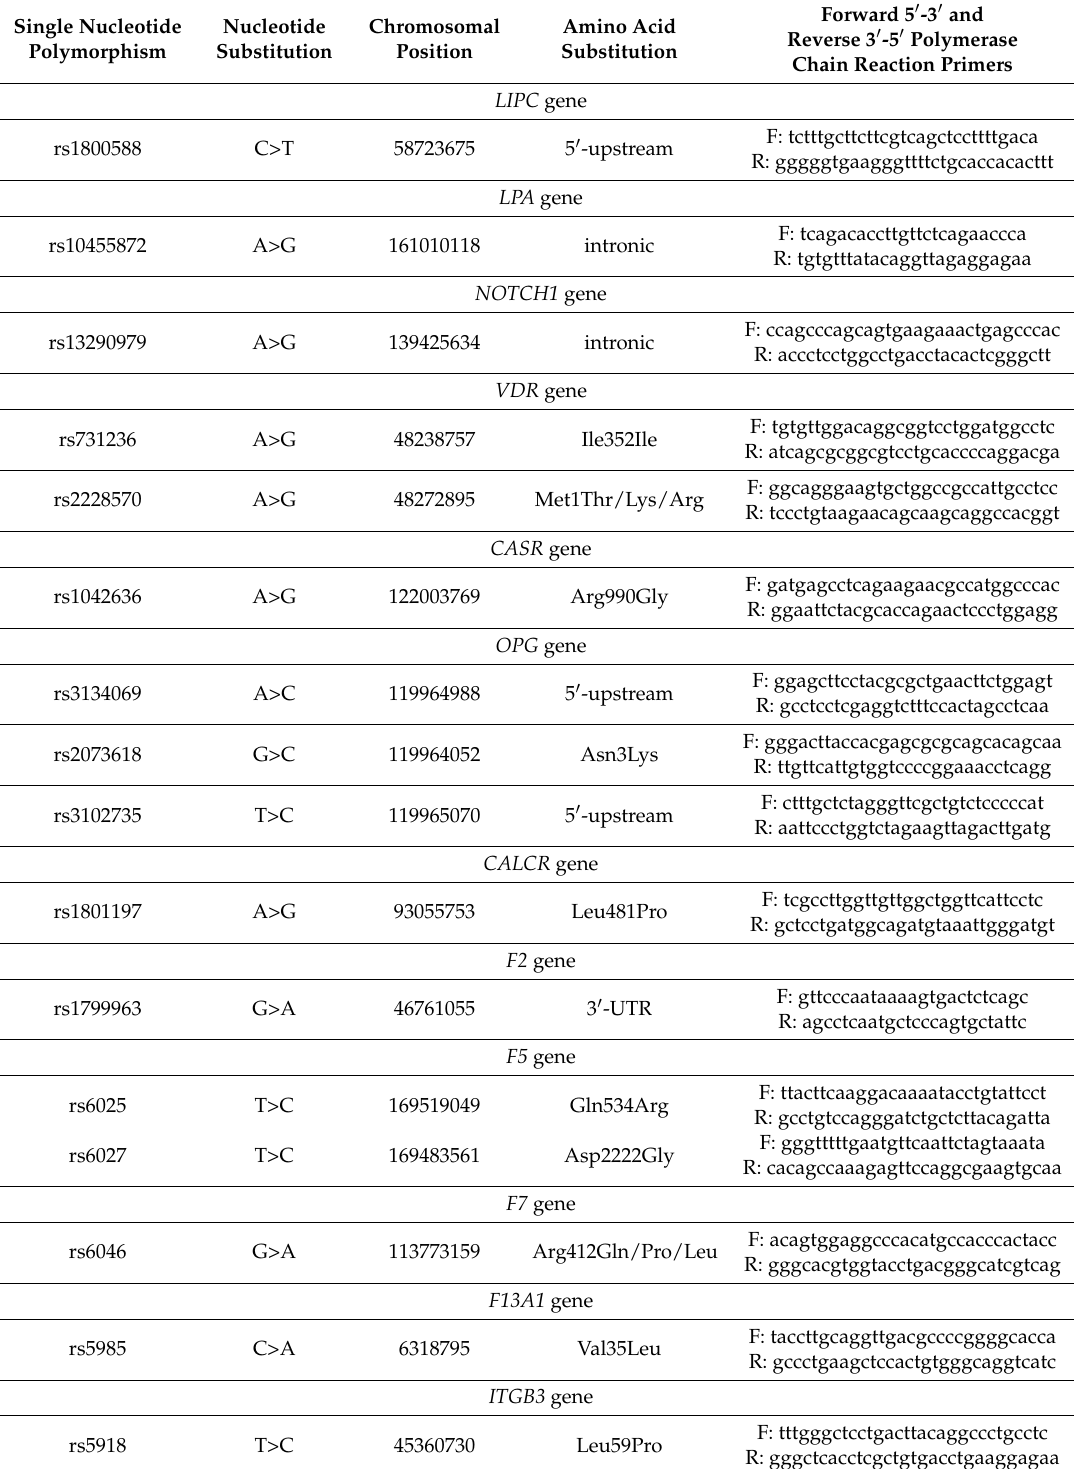
Single Nucleotide Polymorphism